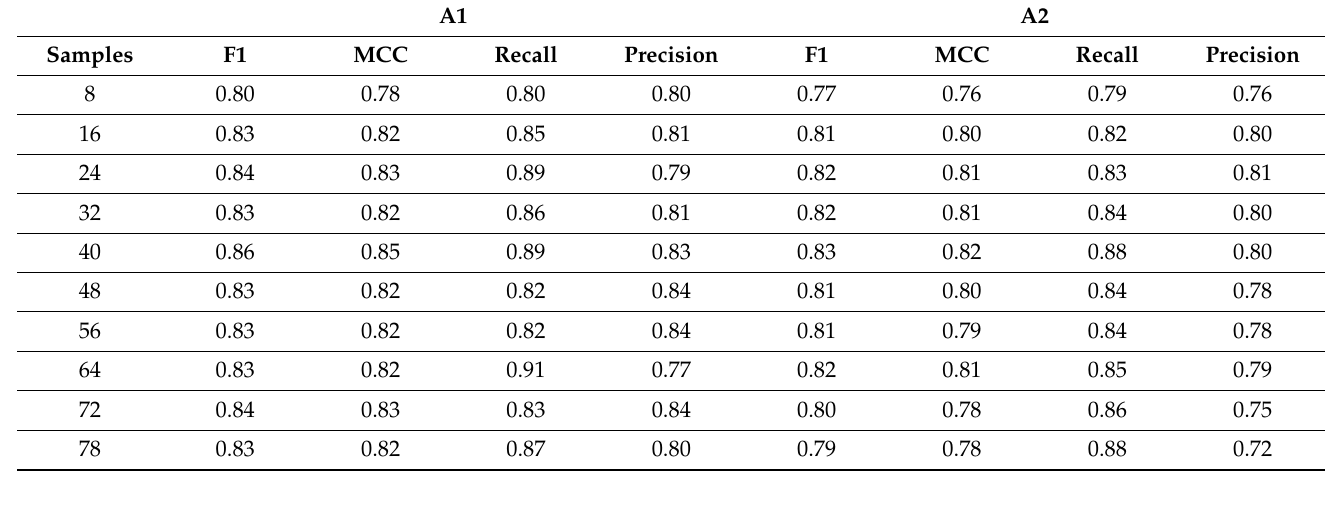
Table 4. Defect detection of PCBs for A1 and A2.